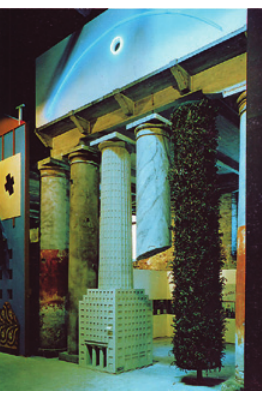
Fig. 33. Hans Hollein. Strada Novissima . Venice Biennale, 1980 (Nakamura 1985) Note: Postmodern architects design playing associations or connections between meaningful objects. In this facade there is a column with the shape of a building (The Chicago Tribune by Loos), that in turn has the shape of a